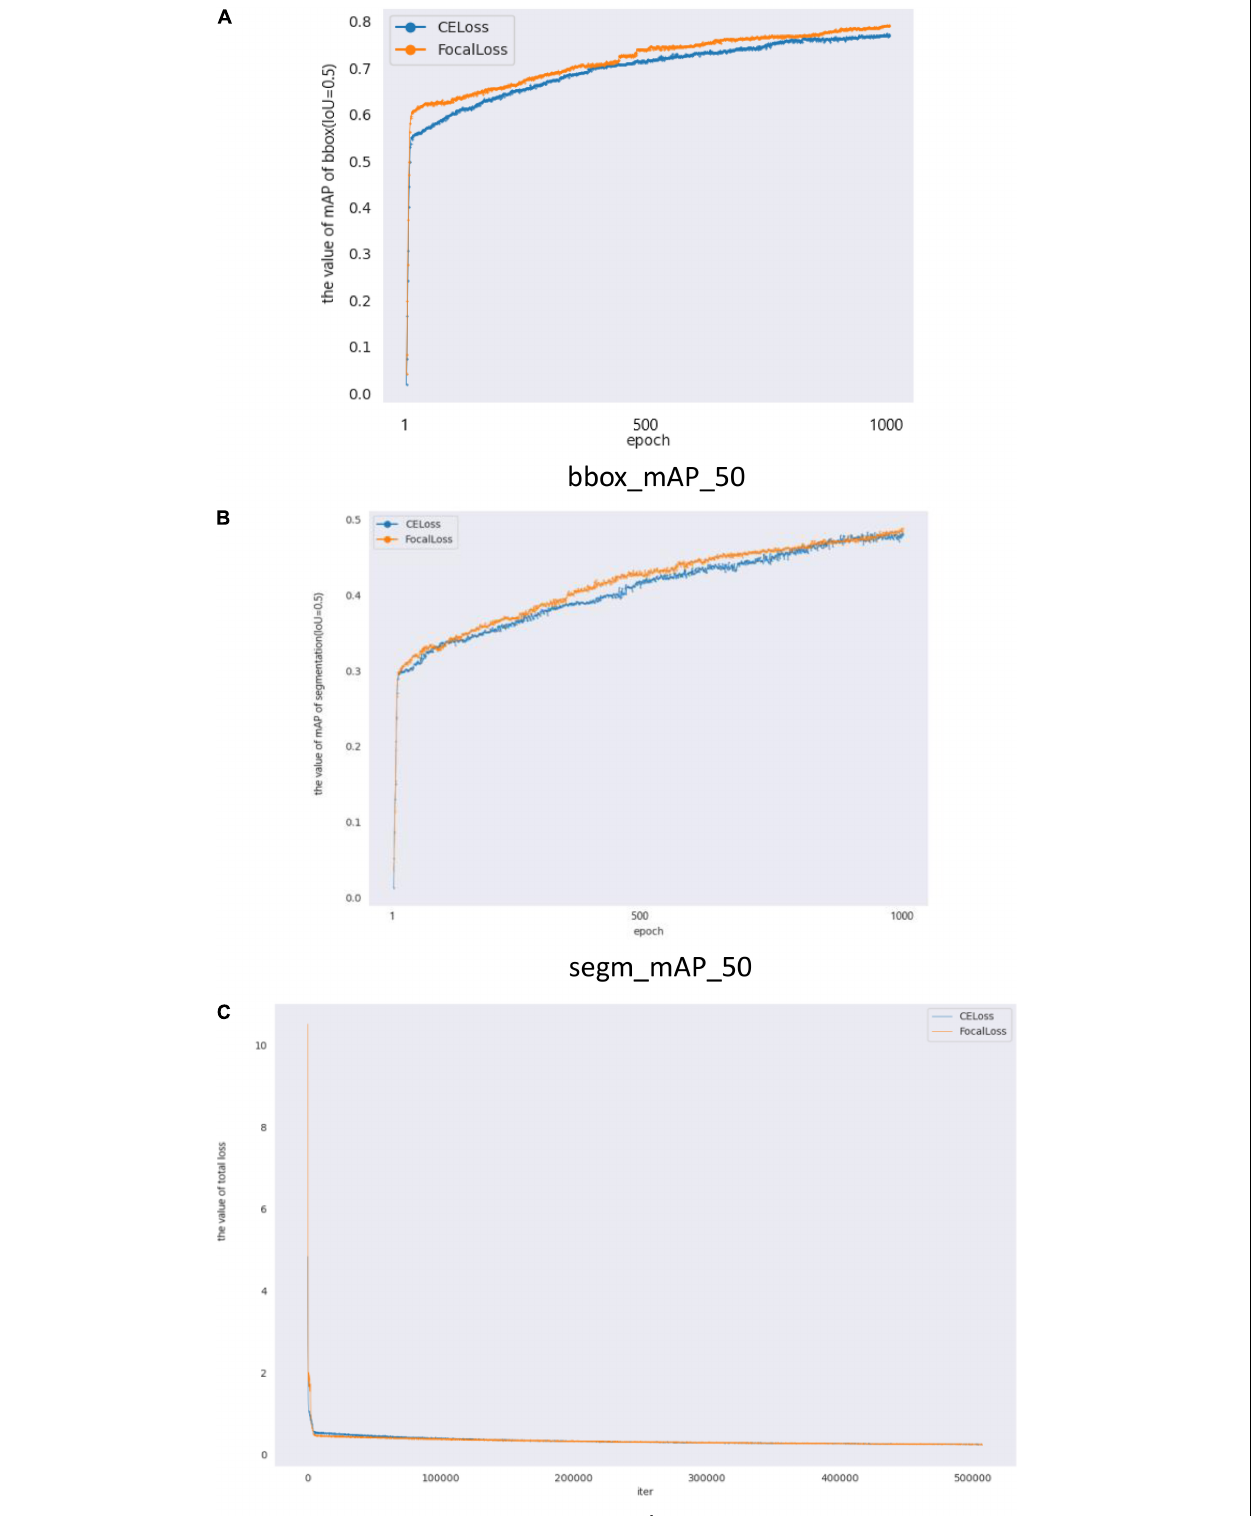
Frontiers in Plant Science |